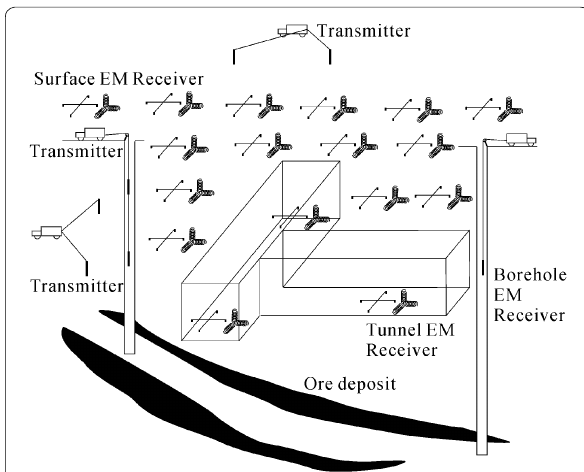
Fig. 1 Experimental layout of the surface-tunnel-borehole electro- magnetic (STBEM) survey